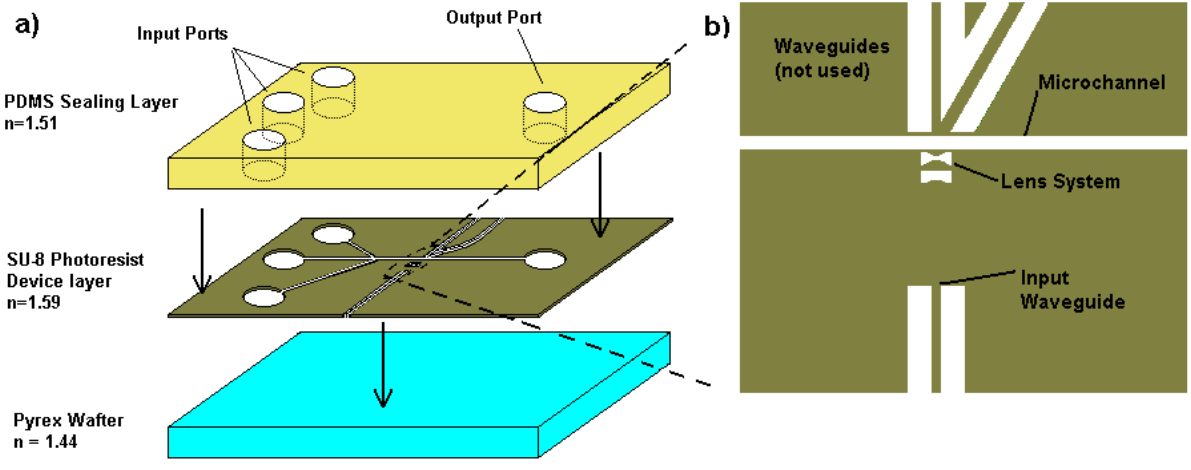
Figure 1. Drawing of the device design ( a ) showing the fabrication steps to form the device layer and the sealing of the channels with the connection to the external pump source. The zoom in ( b ) shows the critical area of the device where the integrated waveguide-lens system is placed next to the channel where a specifically tailored beam will be formed in the centre of the particle